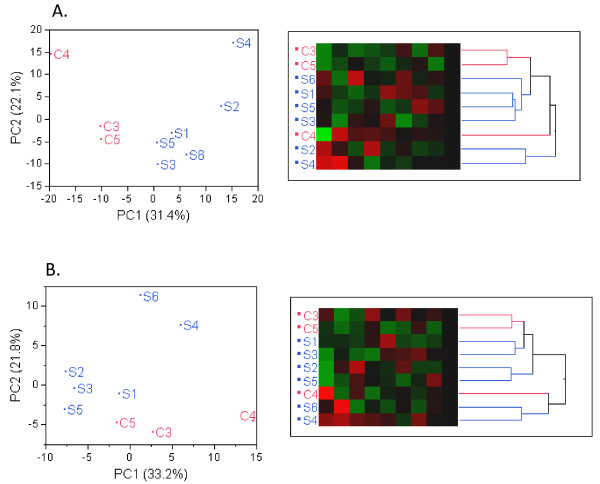
Principal component analysis and hierarchical clustering (A) RNA-seq data. Principal Component 1 (PC1, x-axis) represents 31.4% and PC2 (y-axis) represents 22.1% of total variation in the data. Hierarchical cluster of 9 samples with heatmap representing all 9 PCs in left-to-right order. (B). Exon array data. PC1 vs. PC2 on Exon array data together representing 33.2% and 21.8% of the data variability. Hierarchical clustering shows similarities to that in A, e.g. sample C4 departs strongly from remaining data, samples C3, C5 appear to be neighbors in both data sets.